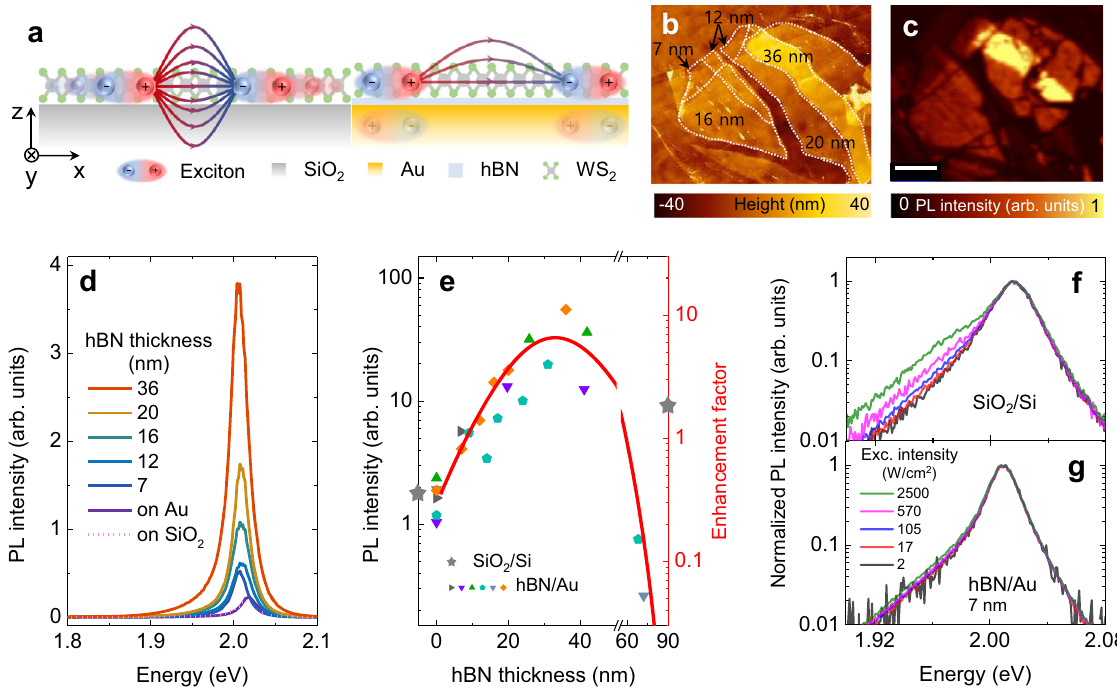
Fig. 1 Impact of the hBN/Au substrate on the PL intensity. a Schematic of exciton-exciton interaction suppressed by the hBN/Au substrate. Shaded arrows represent exciton-exciton interaction. Diluted fi eld lines schematically indicate the reduced interaction by the effect of image dipoles. b AFM height and c PL intensity maps of 1L-WS 2 on the hBN/Au substrate. The scale bar in c corresponds to 7 μ m. d Measured PL spectra of 1L-WS 2 on various thicknesses of hBN on Au. e PL intensities of six 1L-WS 2 samples (same color and shape of dots represent the data sets obtained from the same 1L-WS 2 fl akes) as a function of hBN thickness on the Au surface at the excitation intensity of 2.1 W/cm 2 . The red curve is the calculated enhancement factor (EF) due to the optical interference of the multilayered substrate relative to the suspended 1L-WS 2 . The measured PL intensity and calculated EF of 1L-WS 2 on SiO 2 /Si are indicated by the stars on the left and right Y-axes for comparison. Normalized PL spectra obtained from f 1L-WS 2 on SiO 2 /Si and g . hBN (7 nm)/Au surfaces, respectively, under various excitation intensities. Above 100 W/cm 2 , a trion peak at the low-energy shoulder near 1.98 eV